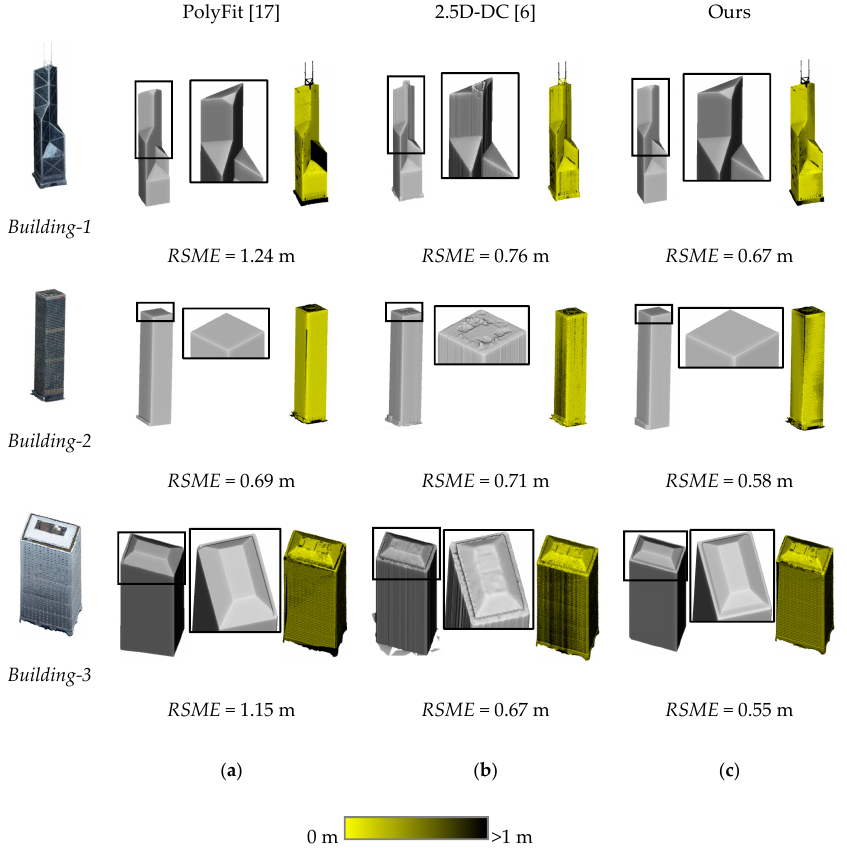
Figure 18. Evaluations of the reconstruction results of three simple buildings using our method, and comparison with the results of PolyFit [17] and 2.5D-DC [6]. ( a ) Results of PolyFit; ( b ) Results of 2.5D-DC; ( c ) Results of our method.